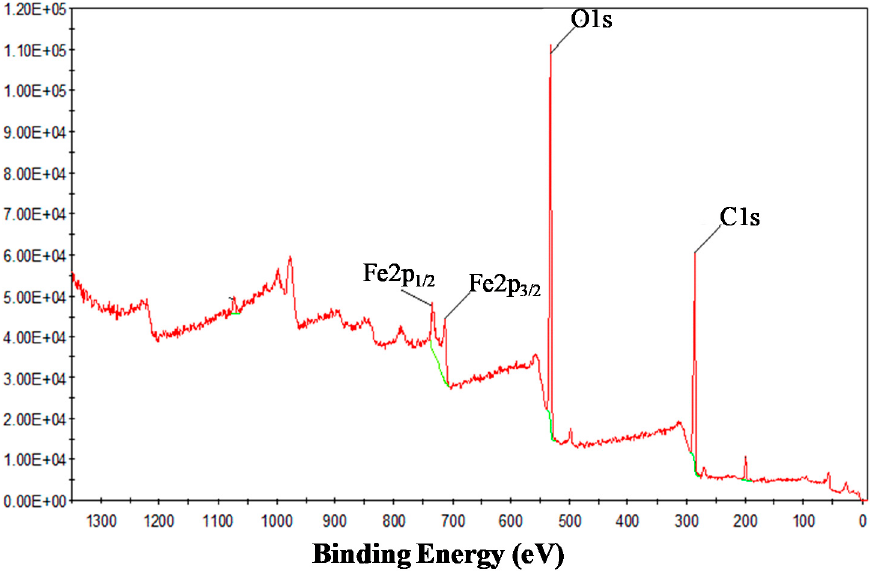
Figure 3. X-ray photoelectron spectroscopy (XPS) profile of IONPs synthesized by T. chebula.